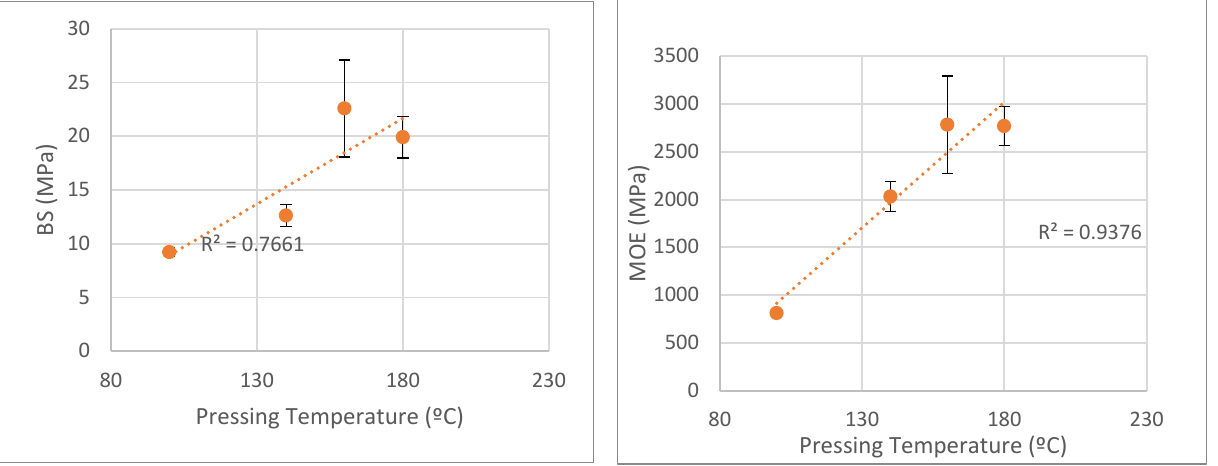
Figure 9. Correlation between bending strength and MOE variation with pressing temperature.